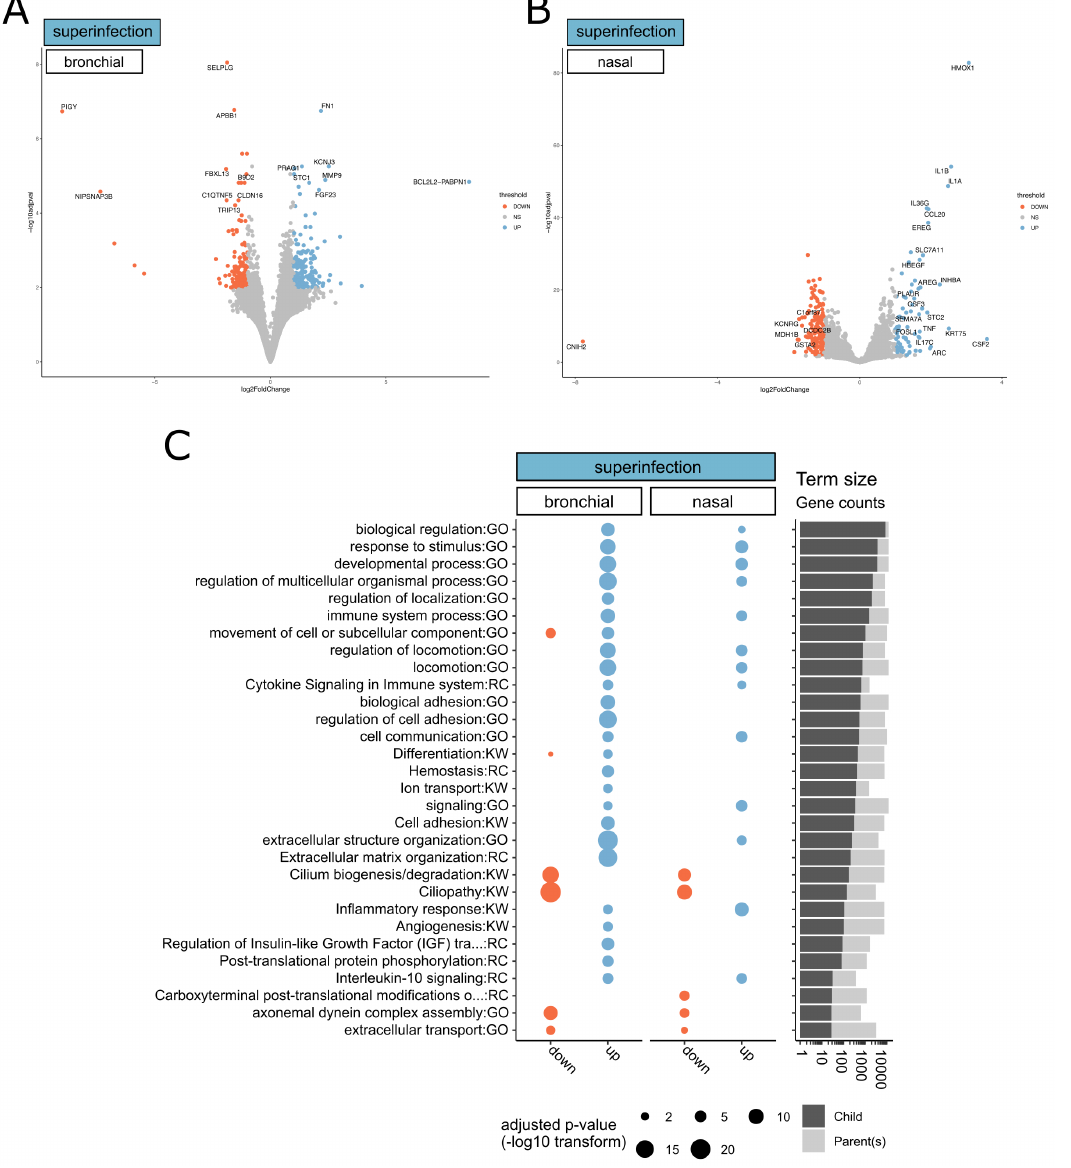
Figure 2. ( A , B ) Volcano plots of di ff erentially expressed genes from ( A ) nasal and ( B ) bronchial tissue superinfected by Aspergillus. We considered significantly modulated genes (CoV + Asp vs. CoV) for both bronchial and nasal HAE (log2(FC) > 1 or < − 1 compared to the CoV condition and Benjamini–Hochberg adjusted p -value < 0.01). The color scale represents the log-transformed fold change values and ranges from low (red) to high (blue). ( C ) Overview of functional enrichment results of SARS-CoV-2 + Aspergillus superinfection vs. SARS-CoV-2 infection. Considering CoV + Asp vs. CoV for both bronchial and nasal epithelium type, significantly up- or down-regulated gene lists ( x -axis) were tested for significant enrichment using the parent-child strategy (see methods). If below the threshold (0.05), the adjusted p-values corresponding to di ff erent terms ( y -axis) are represented by point sizes (see legend). After clustering terms based on gene occurrences (binary distance & Ward algorithm) in 15 metagroups, the two terms with the lowest p-value are represented here. For the complete list of significant terms, see Supplementary Data File 2. The bar plot on the right represents the sizes of enriched terms (called child) in comparison to the size of their parents (see Section